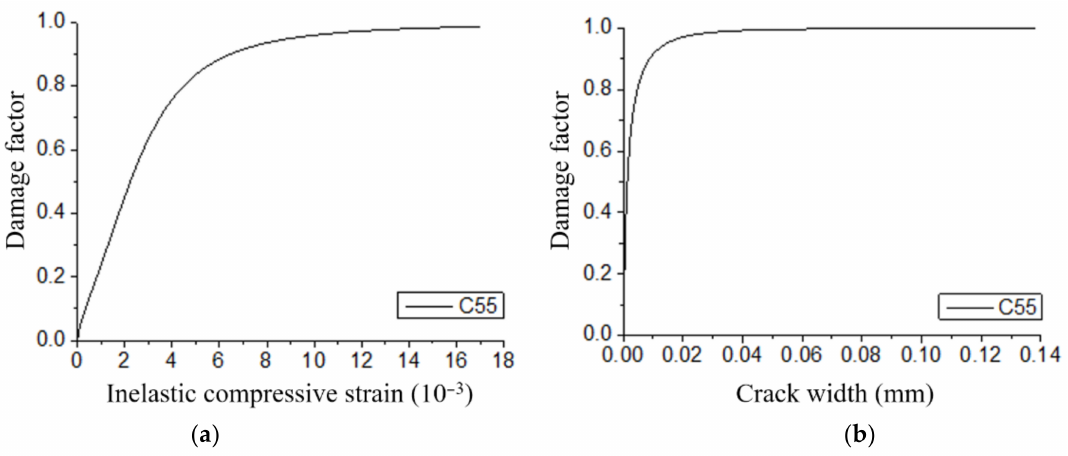
Figure 12. Definition curve of the damage factor: ( a ) Damage factor to inelastic compressive strain; ( b ) Damage factor to crack